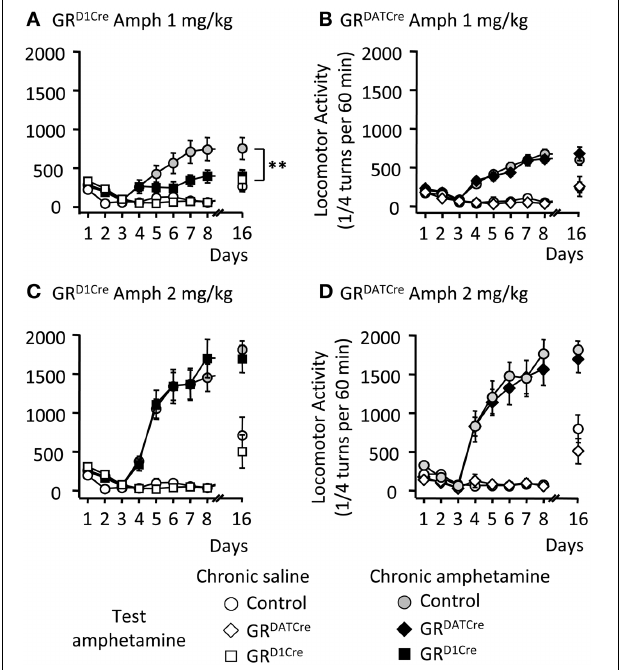
FIGURE 2 | The locomotor sensitization to low dose of amphetamine is selectively abolished in GR D1Cre mice. Locomotor activity is expressed as the sum of ¼ turns in a circular cylinder per hour following repeated drug or saline injections. (A) Locomotor sensitization to 1mg/kg amphetamine daily injections in control (gray circles) and GR D1Cre mice (black squares). White circles and white squares represent control and GR D1Cre mice, respectively, which received daily injections of saline followed by a challenge injection of amphetamine 1mg/kg on the test day. Amphetamine (1mg/kg) induced locomotor sensitization that was abolished in GR D1Cre mice at day 16; interaction Genotype × Treatment F ( 1 , 28 ) = 5 . 2; saline vs. drug: P < 0 . 01; control vs. mutant: ∗∗ P < 0 . 01. (B) Locomotor sensitization to 1mg/kg amphetamine daily injections in control (gray circles) and GR DATCre (black diamond) mice. White circles and white squares represent control and GR DATCre mice, respectively, which received daily injections of saline followed by a challenge injection of amphetamine 1mg/kg following an 8-day withdrawal period. Interaction Genotype × Treatment F ( 1 , 33 ) = 0 . 16; saline vs. drug: P < 0 . 001; control vs. mutant: P = 0 . 6. (C,D) are same than (A,B) , respectively, but with 2mg/kg amphetamine. n = 8–10 per group. (C) Interaction Genotype × Treatment F ( 1 , 36 ) = 1 . 72; saline vs. drug: P < 0 . 001; control vs. mutant: P = 0 . 67.